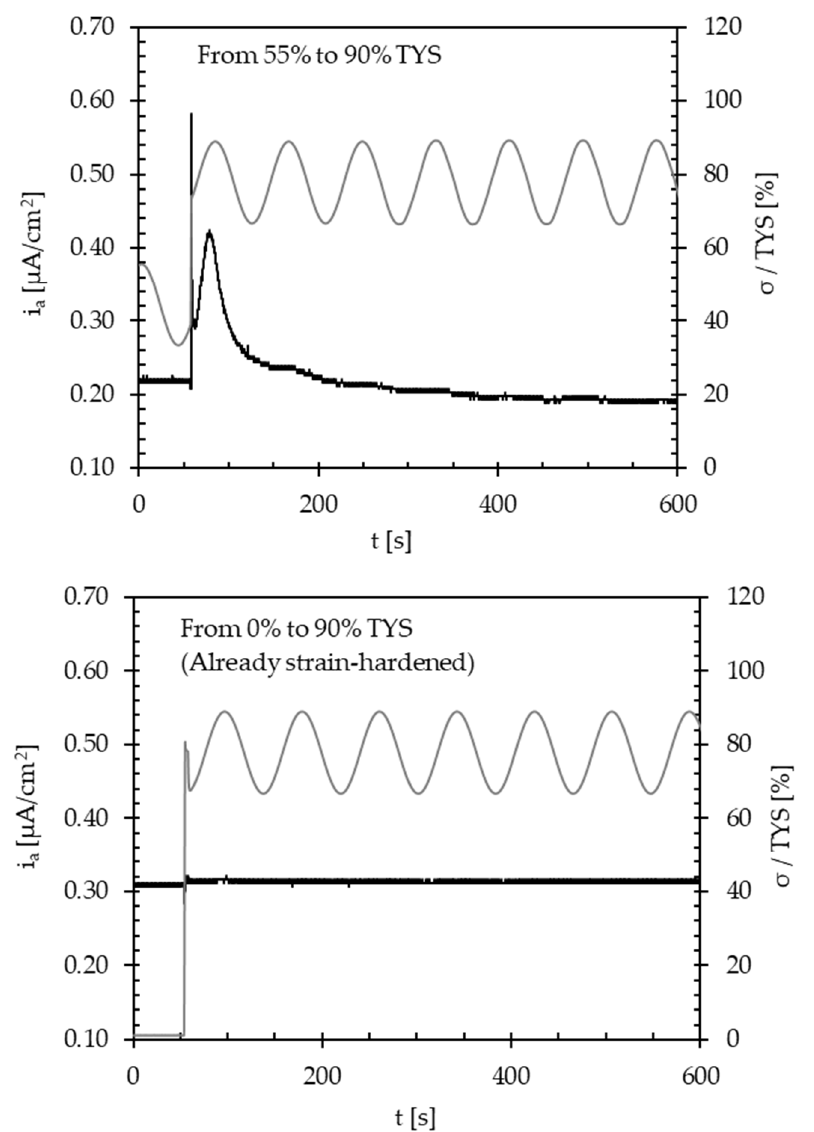
Figure 10. Response to subsequent variations of the maximum load (amplitude = ±10% TYS; frequency = 10 − 2 Hz) on the steady state anodic current (locally strain-hardened steel).